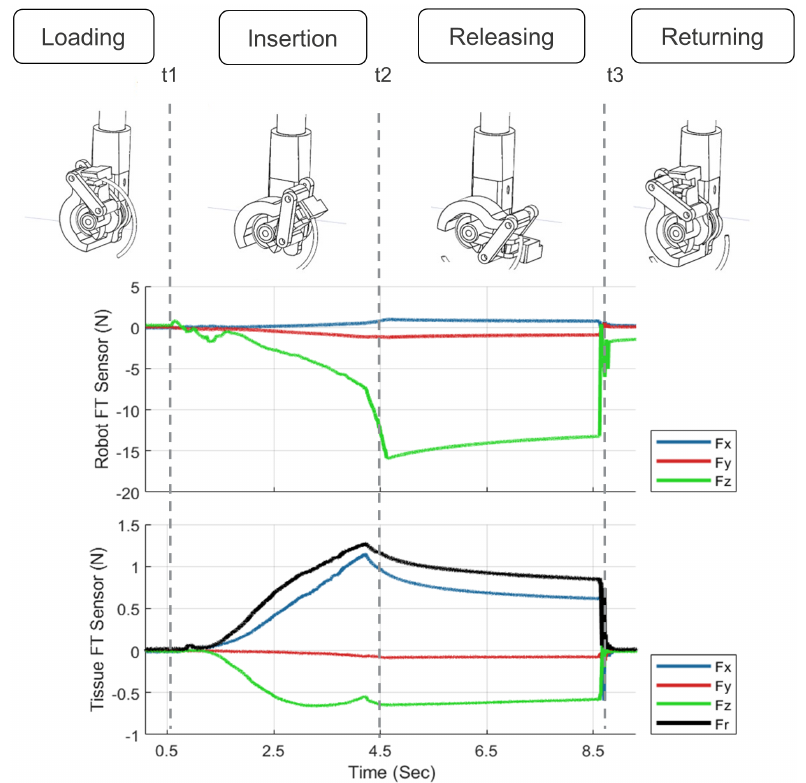
Figure 2. The recorded robot and tissue force sensors data for one cycle of needle